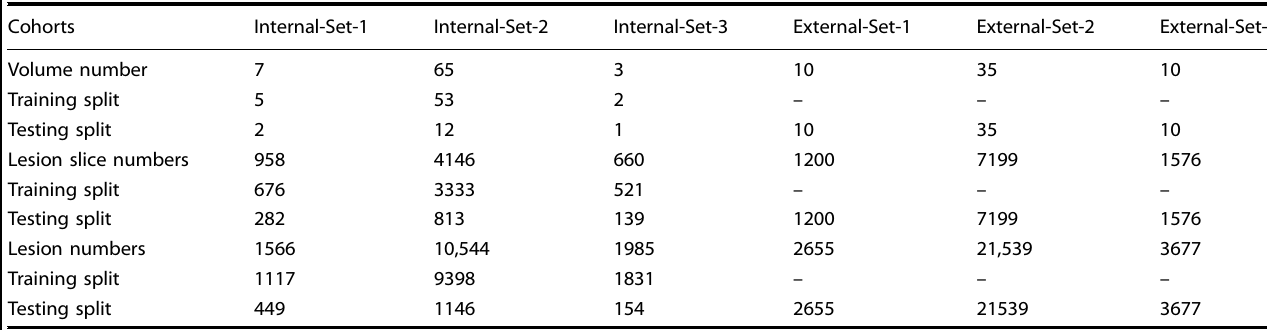
Table 2. Summary of annotated lesions and data splits for AI model training and testing.